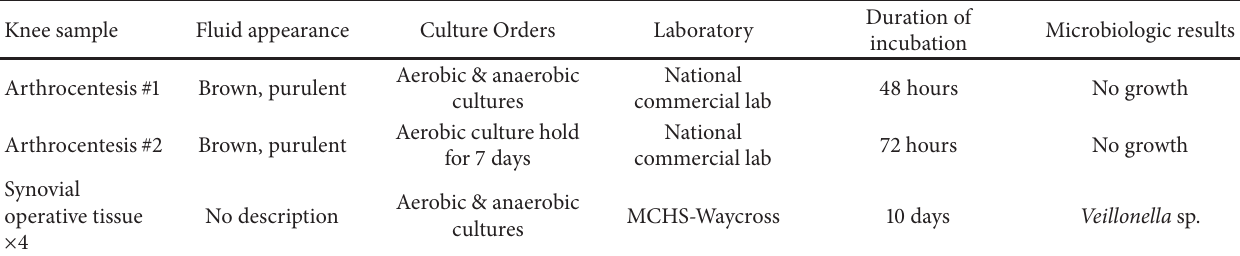
Table 1: Impact of anaerobic incubation time on growth